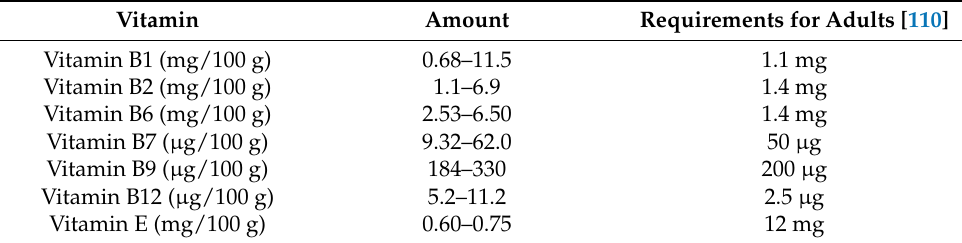
Table 5. Vitamin concentrations in Yarrowia lipolytica protein powder (dry